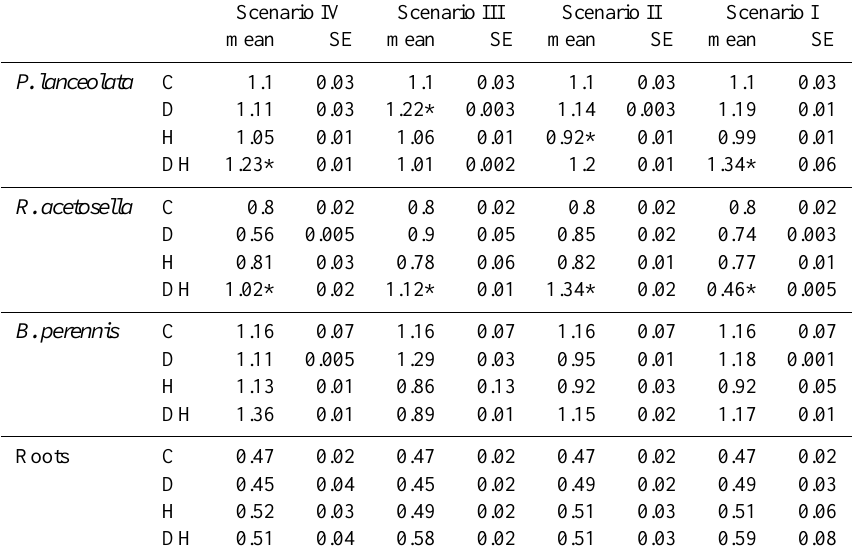
Table 2. Mean tissue nitrogen concentration and standard errors for each species and for the roots in all scenarios. C = control, D = drought, H = heat, DH = drought + heat. Scenario IV = 42-day interval between subsequent events, scenario III = 25-day interval, scenario II = 14- day interval, scenario I = single event. Asterisks indicate significant differences ( P < 0 . 05) between treatment and control.